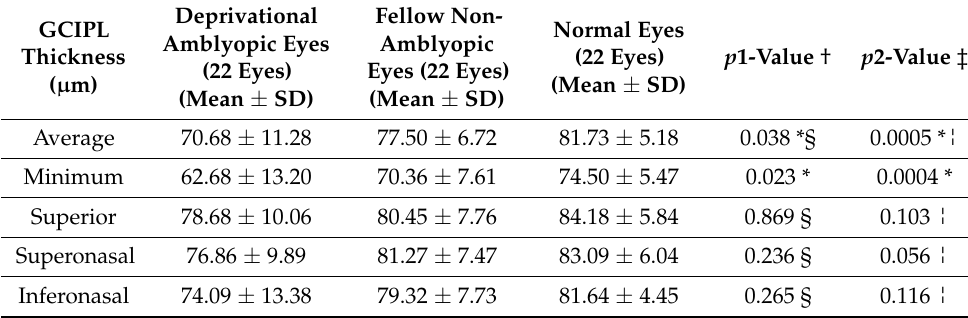
Table 2. Comparison of the mGCIPL thickness between deprivational amblyopic eyes, fellow non- amblyopic eyes and age-matched eyes from control